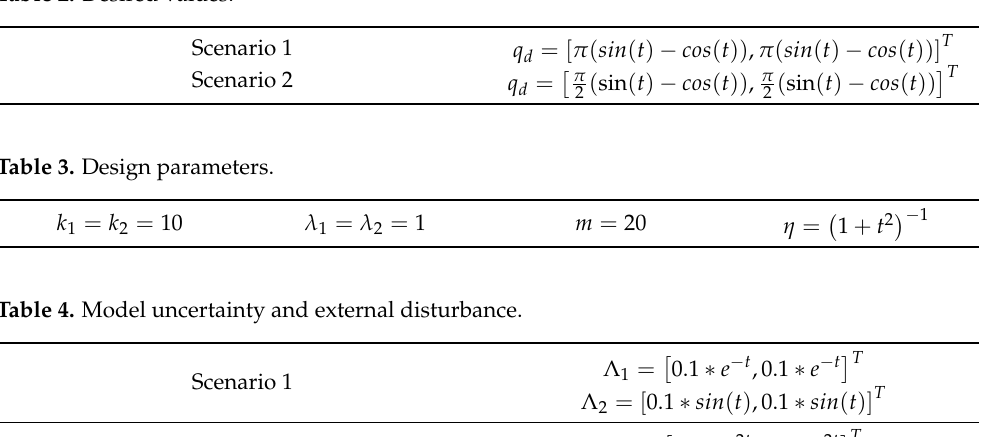
Table 2. Desired values.